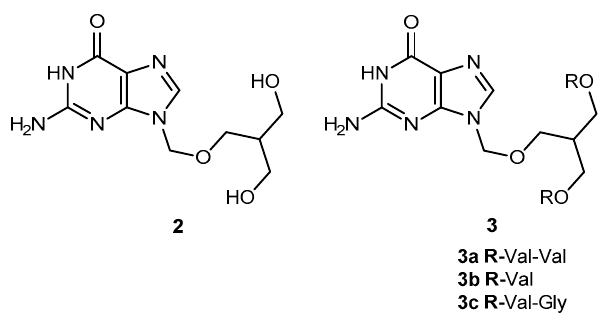
Figure 3. Ganciclovir and its diester prodrugs.